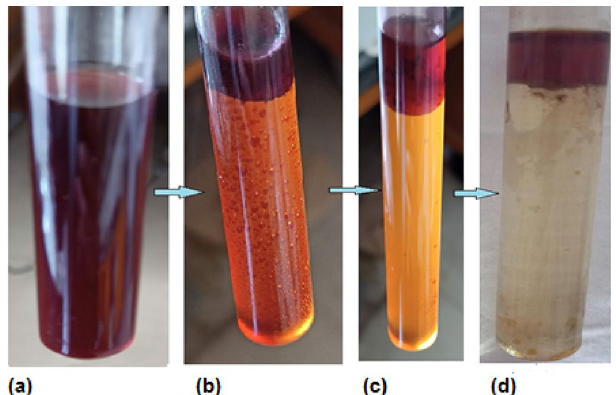
Figure 6. Digital photographs of the sublation process. a ) TBA.[Pd II -(A1)] ion pair in aqueous solution; b ) & c ) TBA.[Pd II -(A1)] ion pair after addition of HOL; d ) TBA.[Pd II -(A1)] ion pair sublated to the MINK organic